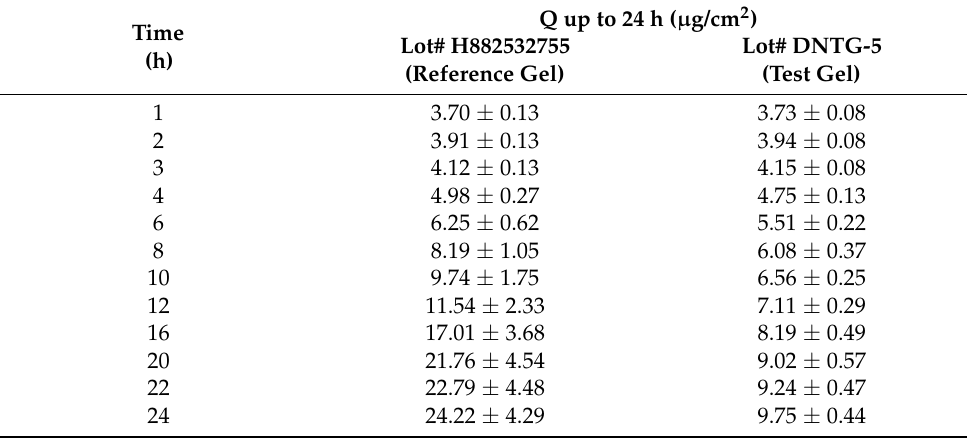
Table 9. Desoximetasone penetration through human cadaver skin up to 24 h.